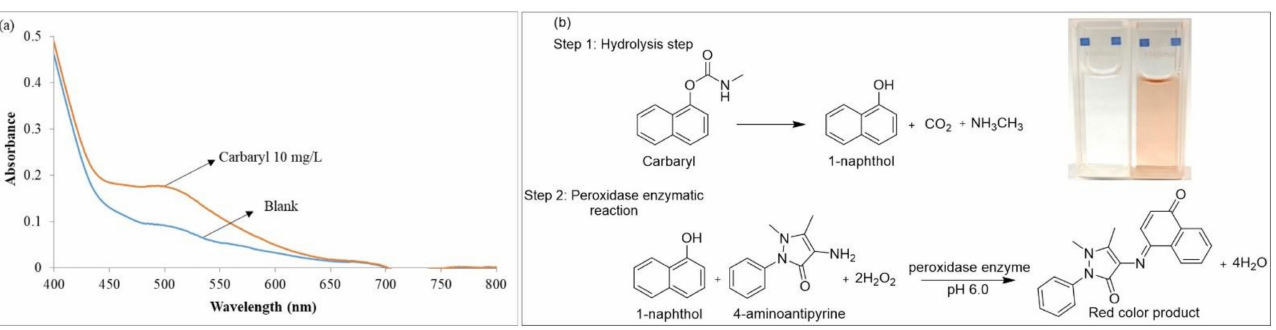
Figure 1. Determination of carbaryl based on peroxidase enzymatic reaction; ( a ) Absorption spectra 10 mg · L − 1 carbaryl in phosphate buffer pH 6.0 and blank; ( b ) suggested mechanism for the reaction of carbaryl with 4-AP in the presence of hydrogen peroxide, exploiting crude peroxidase as a